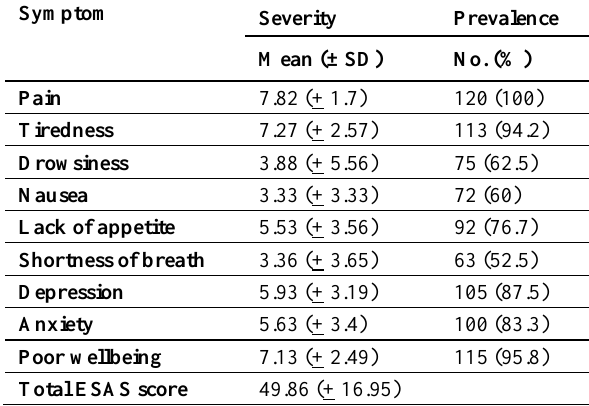
Table 2: Prevalence and severity of